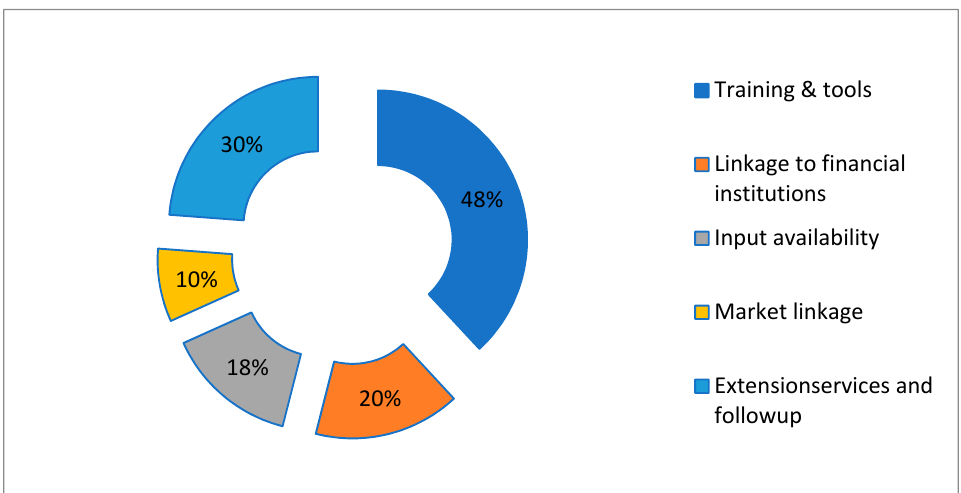
Figure 3. Farmer recommendations for increasing the adoption of conservation agriculture technol- ogy ( n = 500).